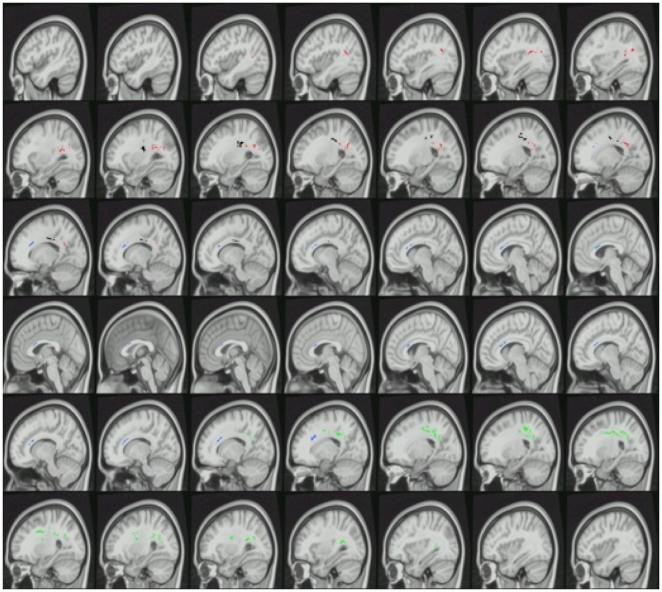
Clusters that had significantly higher mean of the second and third eigenvalues (λ⊥) in cocaine-dependent subjects compared to control subjects are overlaid in color on a montage of sagittal slices of the MNI152 standard space template T1 brain image.Green voxels represent λ⊥ cluster 1, red voxels represent λ⊥ cluster 2, blue voxels represent λ⊥ cluster 3, and black voxels represent λ⊥ cluster 4 in Table 2. The slice in the upper left corner is in the left hemisphere; the lower right corner slice is in the right hemisphere. Note that the cluster colors were arbitrarily chosen to identify different clusters and do not represent a scale of t values.